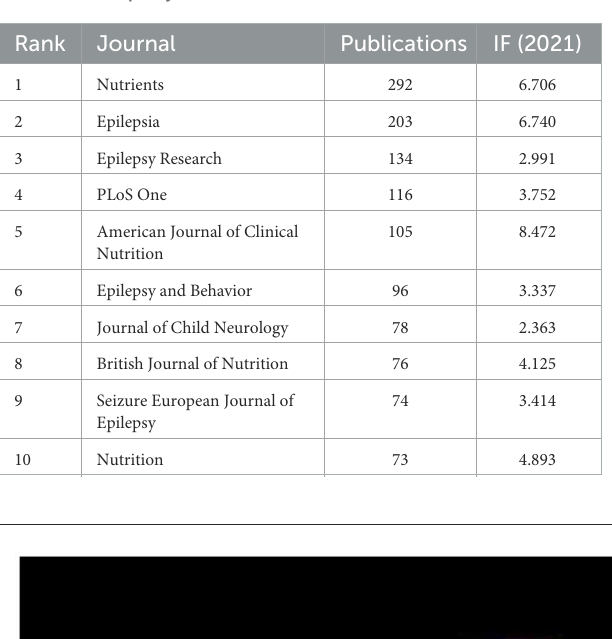
Figure 6 illustrated the dual- map overlay of journals that produced literature linked to the topic of LChD. On the map, the right labels represented the disciplines of the journals that published the cited papers, while the left labels represented the fields of the citing journals. Citation links can show the in and out of the citation dataset. Figure 6 showed 5 reference pathways. Three yellow pathways indicate